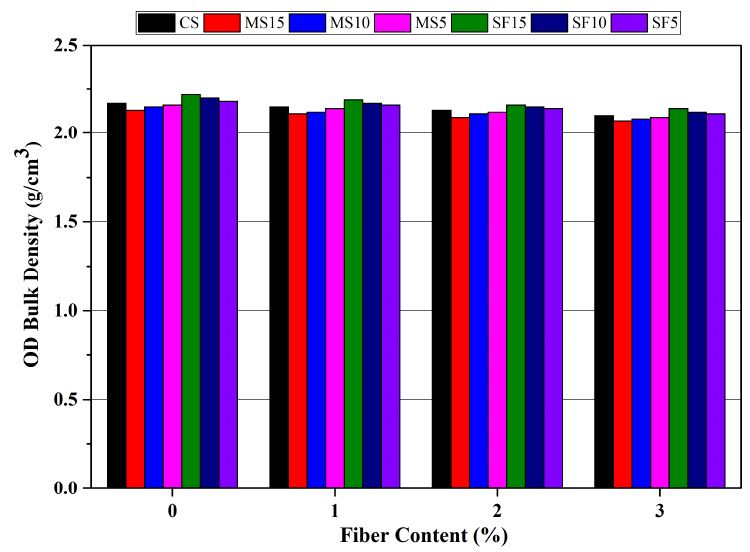
Figure 5. Dry bulk density values of the mortar samples.